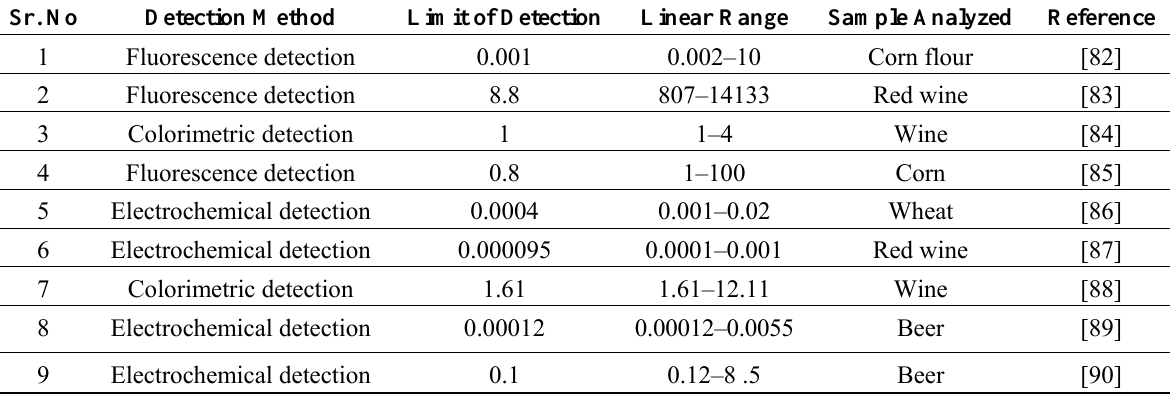
Table 3. Structure switchable aptamer based assays for